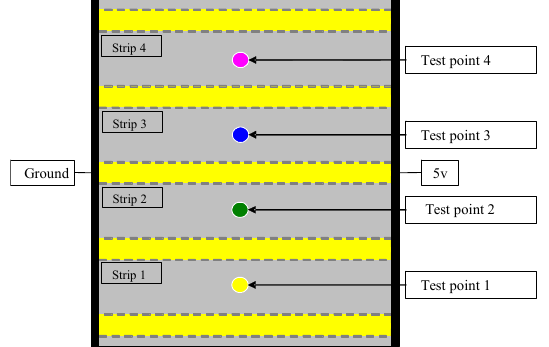
Figure 16. The second scenario connections.